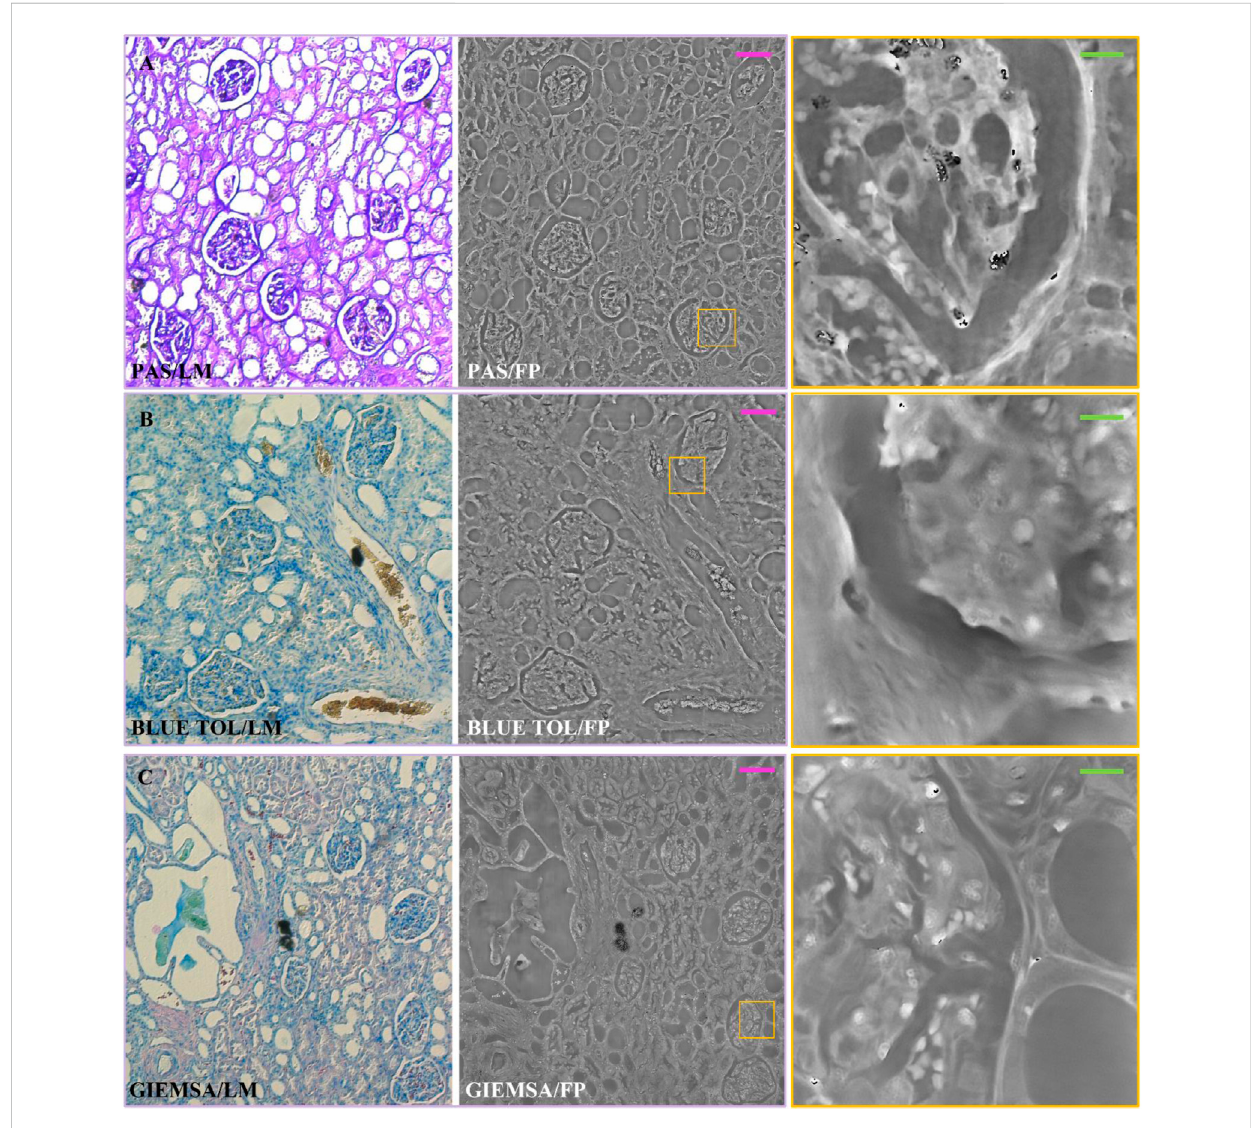
FIGURE 3 Stained renal tissue slides: Renal tissue portions with 3 µm thickness are stained with various blue dyes and captured by (left) LM and (center/right) FP. (A) PAS; (B) BLUETOL; (C) GIEMSA.Scalebars:105 µm.Ontheright,thezoomedpatchesofthecorrespondingyellowboxeshavethegreenscalebar of ~13